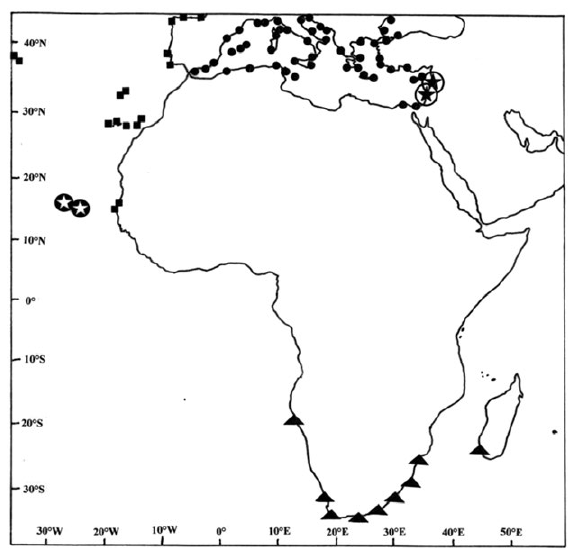
Fig. 5. – Geographical distribution of the species of the Diplodus sargus group in the eastern Atlantic, Mediterranean Sea and south- western Indian Ocean. Circles, Diplodus sargus ; triangles, D. cap- ensis ; squares, D. cadenati ; black stars, D. levantinus n. sp.; white stars, D. lineatus .